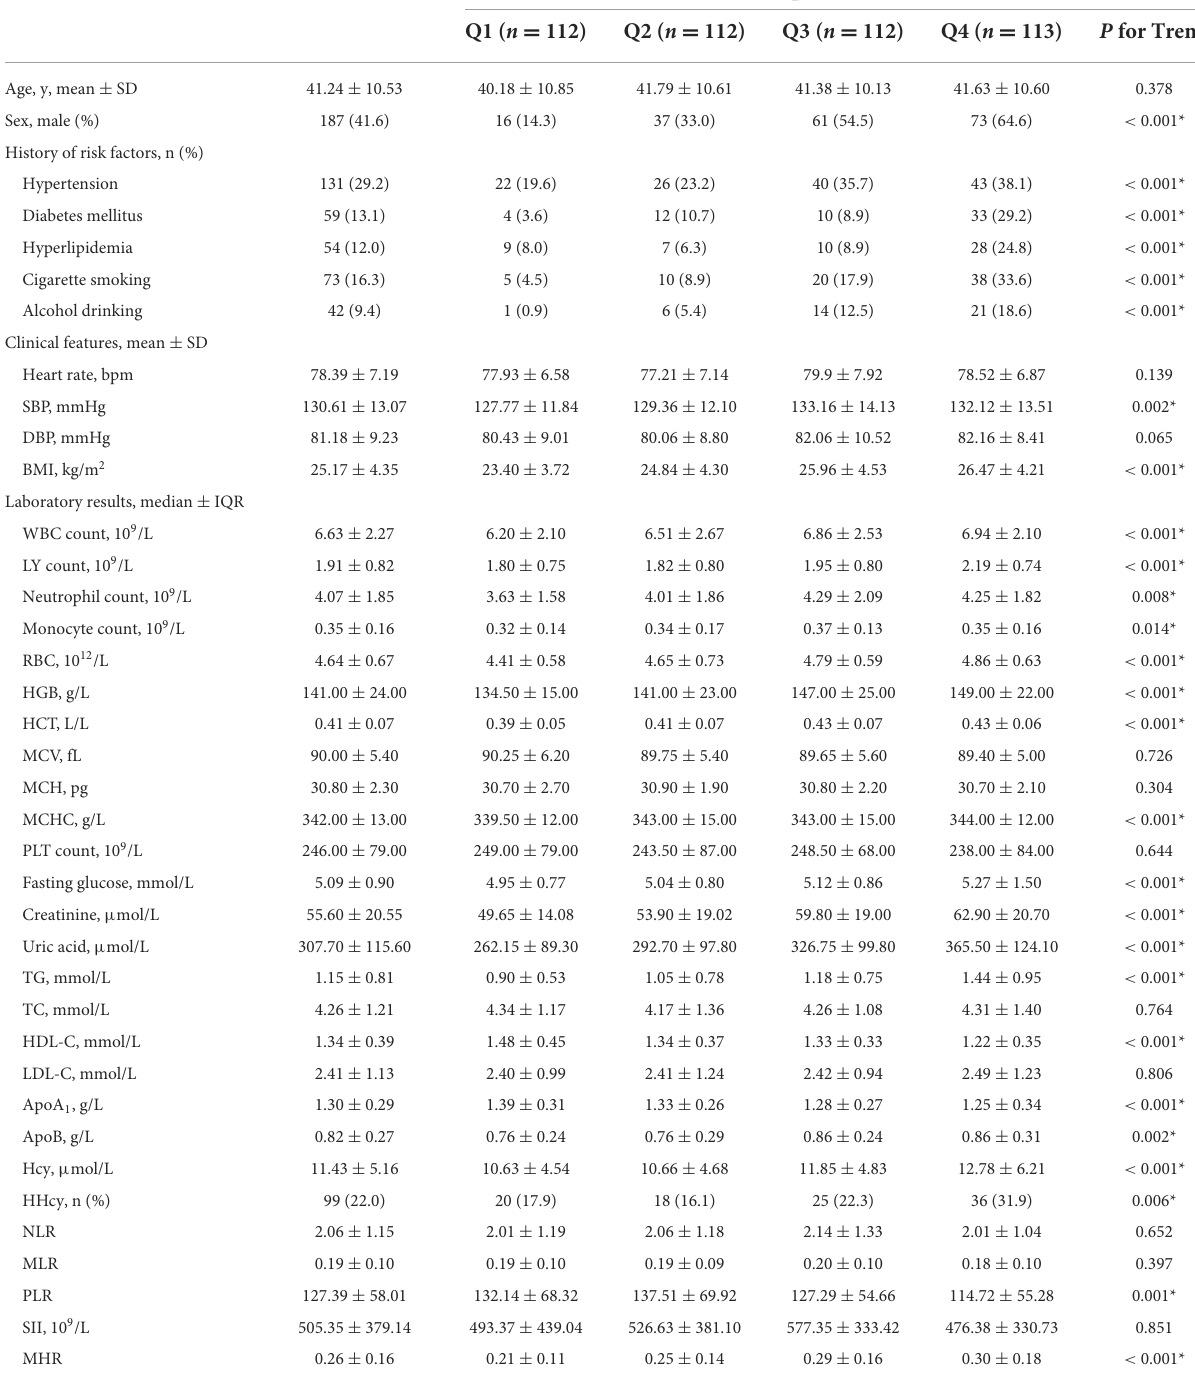
TABLE 2 Characteristics of HCs and MMD patients according to BCAAs